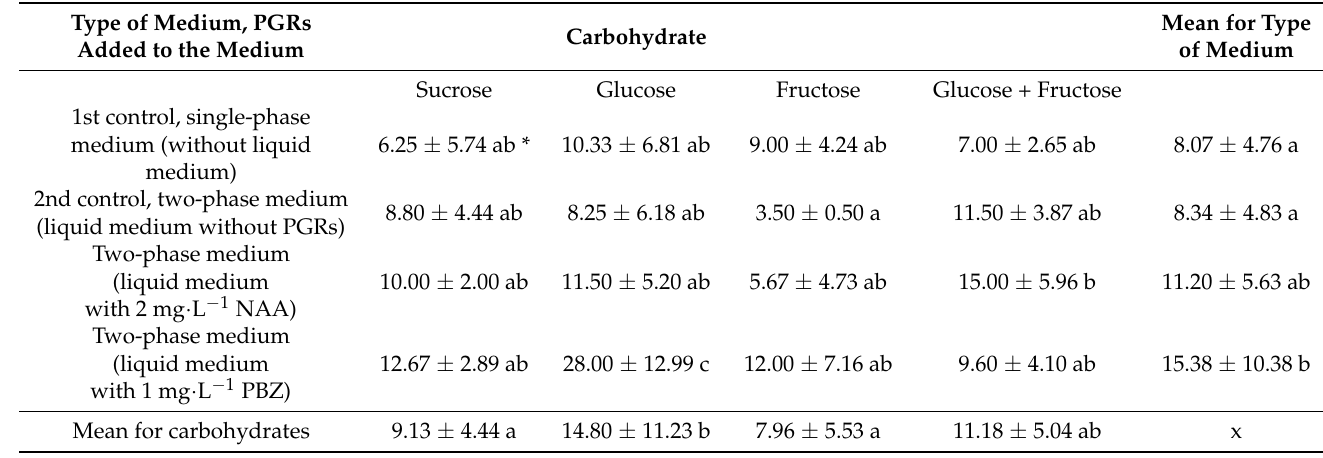
Table 4. Effects of the type of medium and plant growth regulators (PGRs) and the after effect of different carbohydrates on the total number of bulbs the tulip cultivar ‘Heart of Warsaw’ formed in